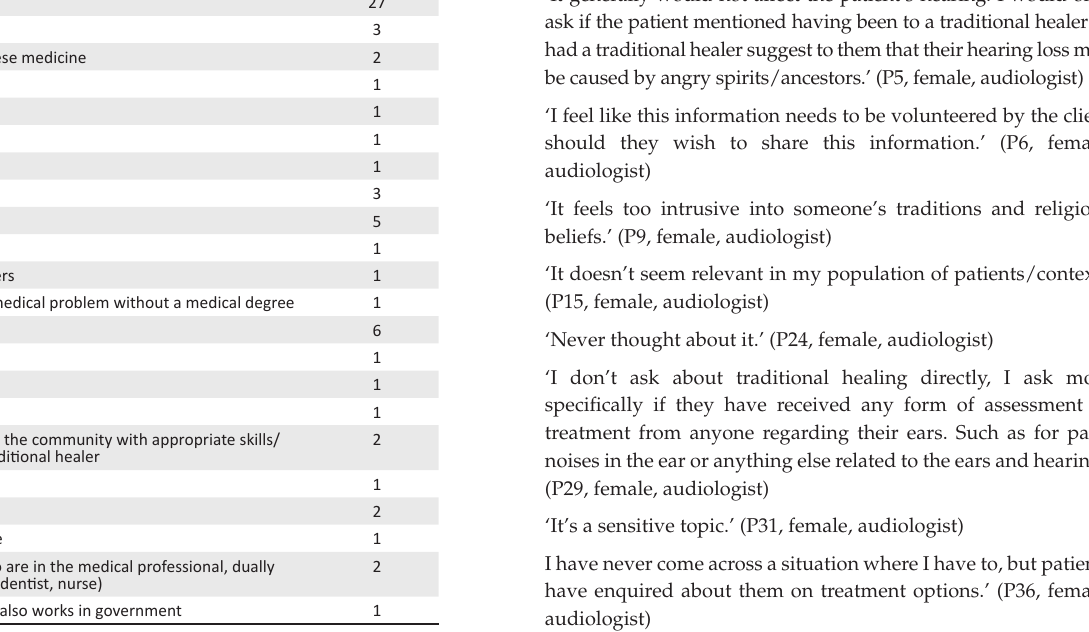
TABLE 2: Examples of traditional healers. Example of traditional healers provided by the participants Number of